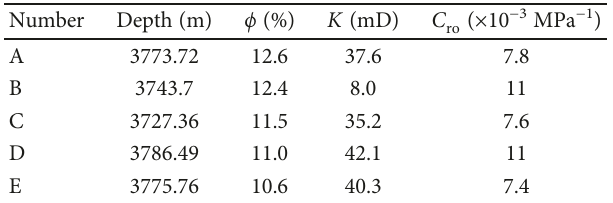
threshold pressure gradient. The formation pressure distri- bution is shown in